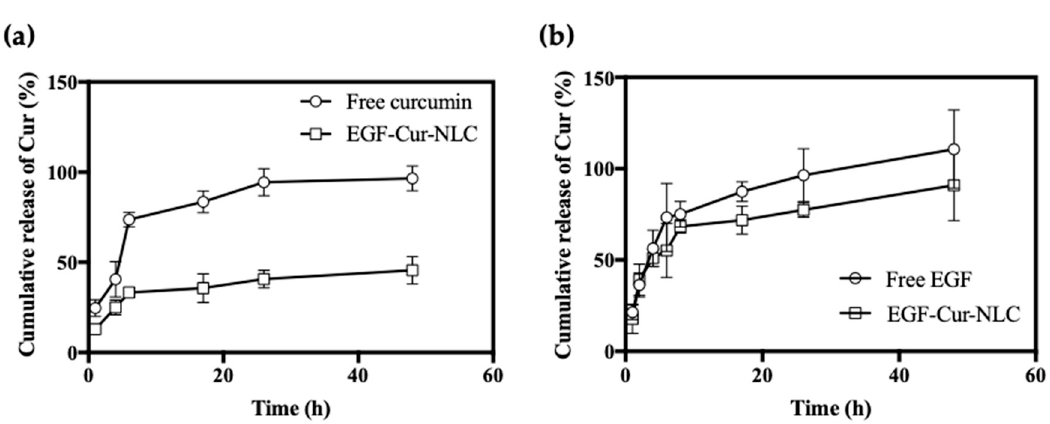
Figure 3. In vitro drug release profile of ( a ) curcumin form free curcumin and EGF–Cur-NLC in 50% ethanol solution, ( b ) EGF from free EGF and EGF–Cur-NLC in PBS solution at pH 7.4. The data are shown as mean ± SD ( n = 3). Table 2. Parameters of Korsmeyer–Peppas model for drug release from EGF–Cur-NLC.